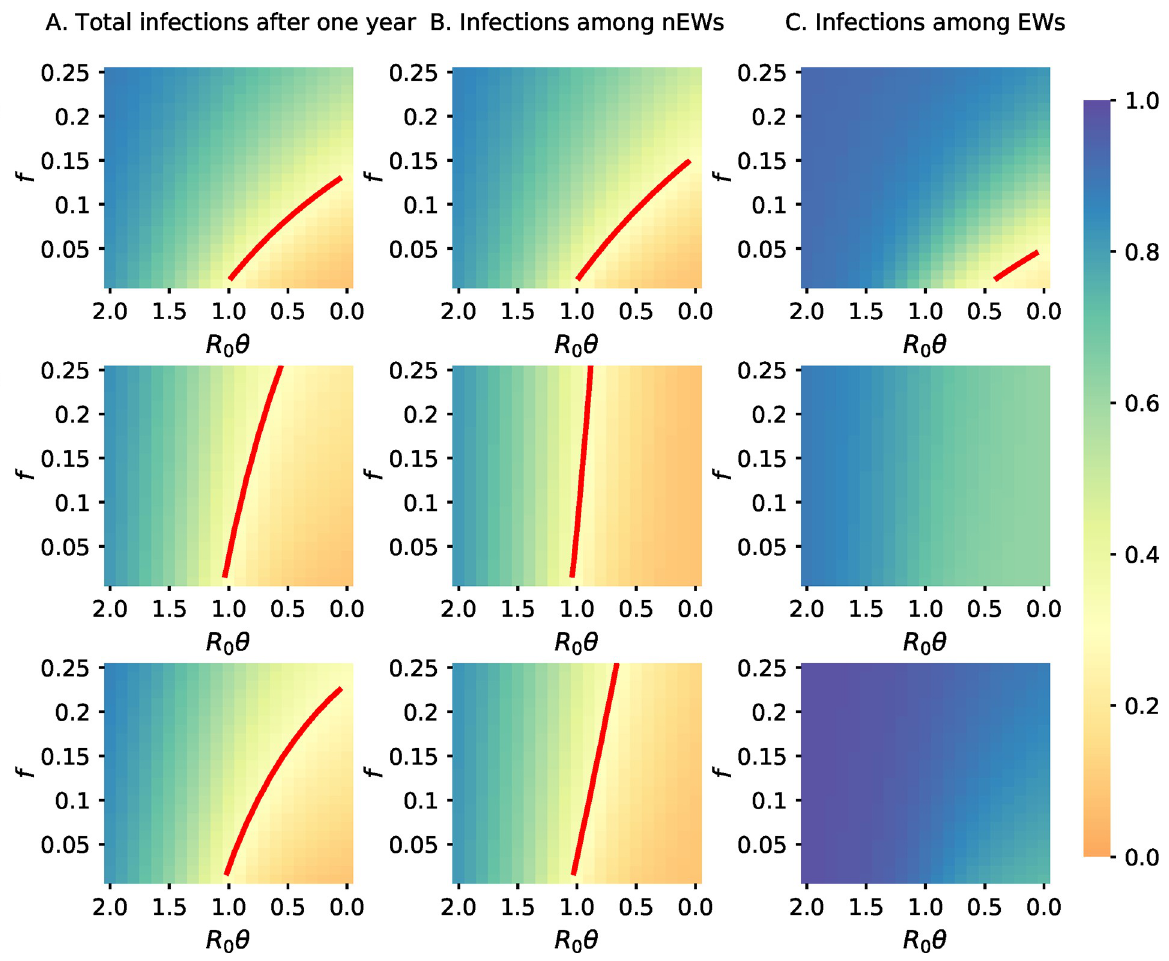
Fig 3. Heatmaps of cumulative infections after a year in the total population (A), in nEWs (B), and in EW (C). The red contour lines correspond to f , θ values for which the prevalence of infection over a year in the population or subpopulation is equal to the prevalence without EWs (i.e., f = 0 ) and R 0 θ = 1 . These contour lines are absent in the two bottom right-most panels, because when f > 0, the prevalence in EWs is greater than that expected with f = 0 and R 0 θ = 1. For equivalent figures with alternative choices of parameter values, see Section 3 and Figs 17–29 in S1 Appendix.